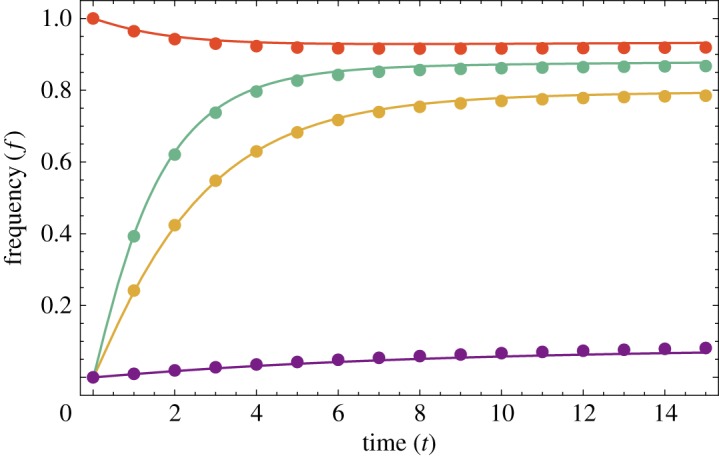
Comparison of frequencies fi(t) of variant A at the centres of the four cities in figure 2 (plotted as points) to the solution of the set of approximate ODEs (3.5) (plotted as lines). Colour scheme: red, large city which begins with variant A; green, first city to adopt A in figure 2; yellow, second city to adopt A and purple, large city which never fully adopts A.